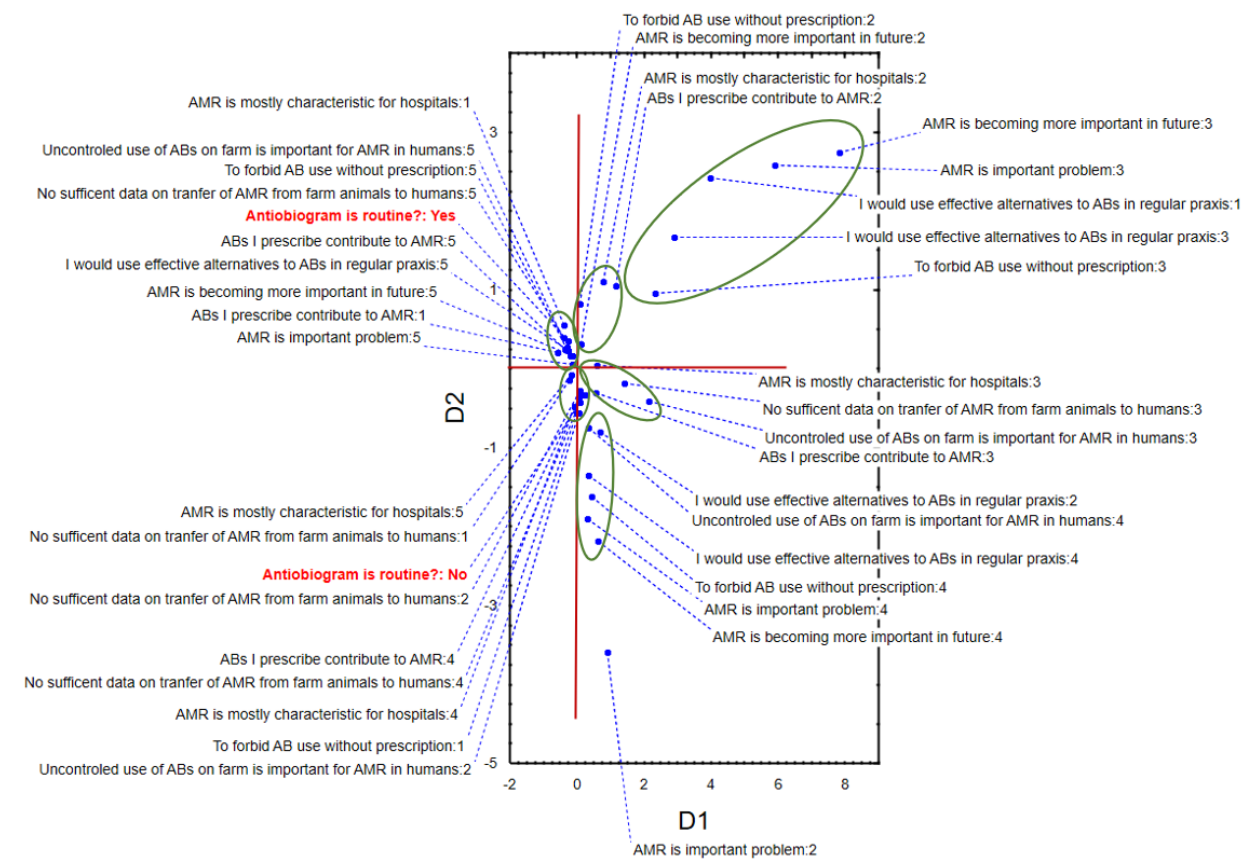
Figure 2. The position of respondents’ answers in space defined by the first two multiple correspondence axes—knowledge on AMR and antibiotic treatment of mastitis in cows.